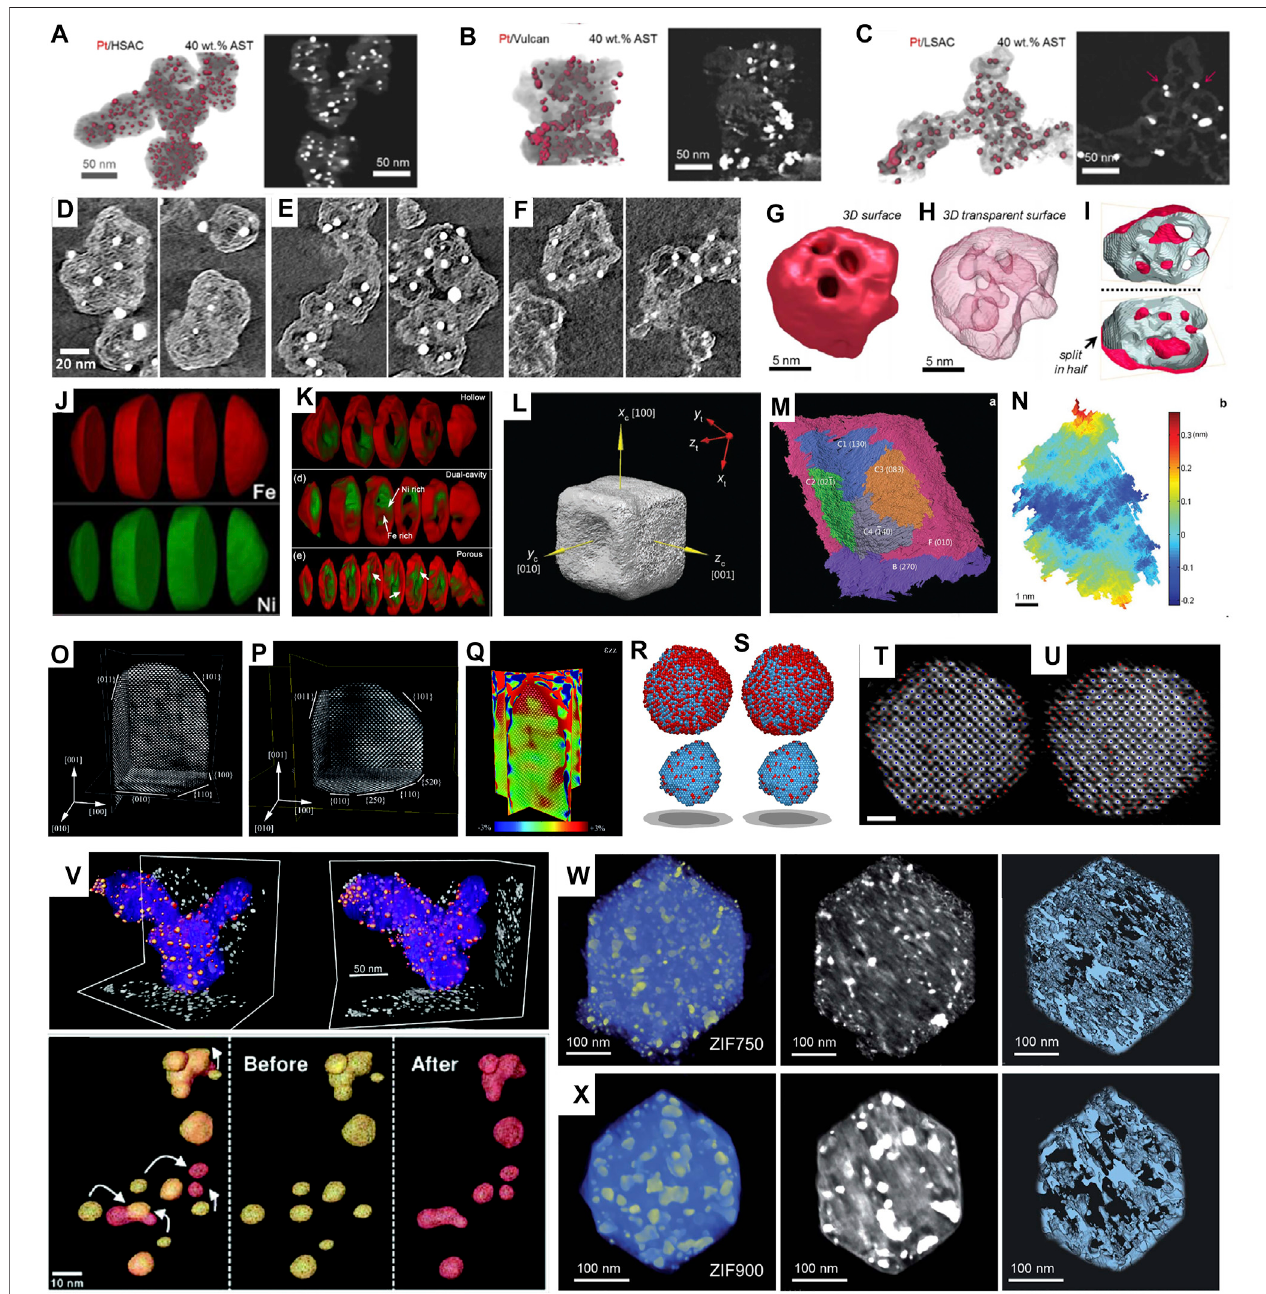
FIGURE 2 | (A – C) 3D reconstructions and representative cross-sectional z-slices of volumes of 40 wt% Pt catalysts on (A) HSAC, (B) Vulcan, and (C) LSAC supports after ASTs of MEAs. Reprinted with permission from (Sneed et al., 2017). Copyright 2017, American Chemical Society. (D – F) Closeup of representative tomography cross sections for three different carbon blacks , showing the microporous structure in solid carbon (Ko et al., 2021). (G – I) surface render (G) , transparent surface render (H) , and surface cut in half (I) showing internal pore structure of electron tomography results for a Pt-Co spongy particle. (Sneed et al., 2018) (J,K) Chemically sensitive tomographyofparticlesbefore (J) and after (K) fulloxidation.Reprinted withpermission from(Xiaet al.,2018).Copyright2018,AmericanChemical Society. (L) The 3D surface morphology of the Au@Pd nanocatalyst with concave facets. (M) The segmentation of the surface oriented along (010) of the Au@Pd concavenanocube. (N) Roughness map oftheC3facetin (M) .Reprinted withpermission from (Xiaetal.,2016).Copyright2016, WILEY-VCH. (O – Q) atomic-resolution reconstruction of an Au nanorod. Reprinted with permission from (Bals et al., 2014). Copyright 2014, WILEY-VCH. (R – U) 3D atomic models (Pt in blue and Fe in red) of particlewithatotalannealingtimeof9 min (R,T) and16 min (S,U) ,respectively, determined byAET(scalebar: 1 nm).Reprintedwithpermissionfrom(Miao etal.,2020). Copyright 2020, Cambridge University Press. (V) 3D reconstruction of nanocatalyst particles before (yellow) and after (red) electrochemical aging. Reprinted with permission from (Yu et al., 2012). Copyright 2012, American Chemical Society (W – X) 3D tomographic reconstruction, corresponding orthoslices, and porous structure of ZIF annealed at (W) 750 ° C for 1 h and (X) 900 ° C for 1 h, respectively, (Wang et al., 2021b).